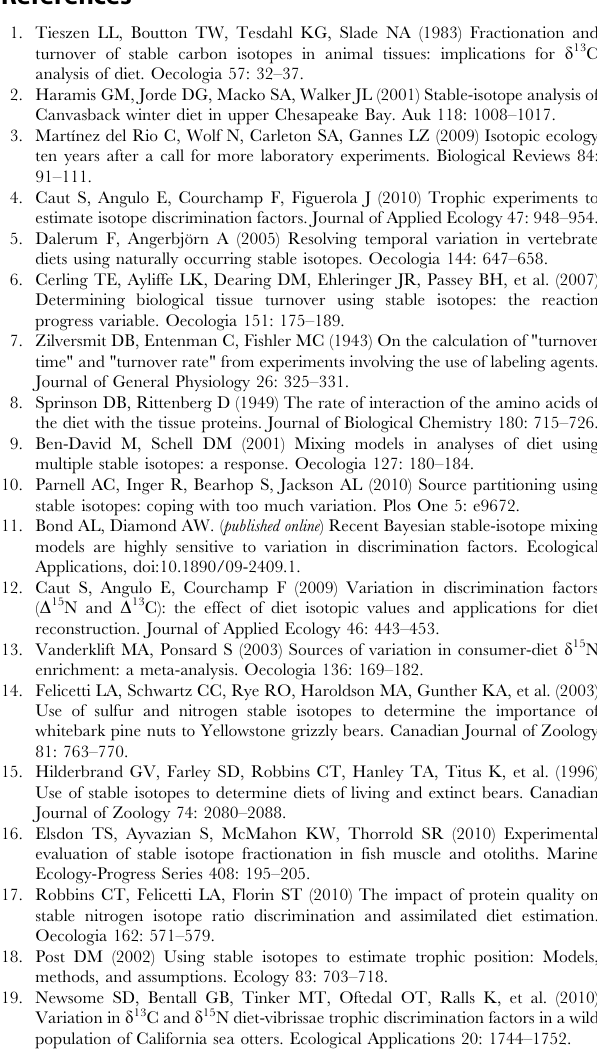
Table S4 Mean d 13 C, d 15 N, and CN ratio ± SD ( % ) (in normal, italic, and bold fonts, respectively) of arctic foxes according to tissues, population structure and diet; 2007-2008, A˚s,